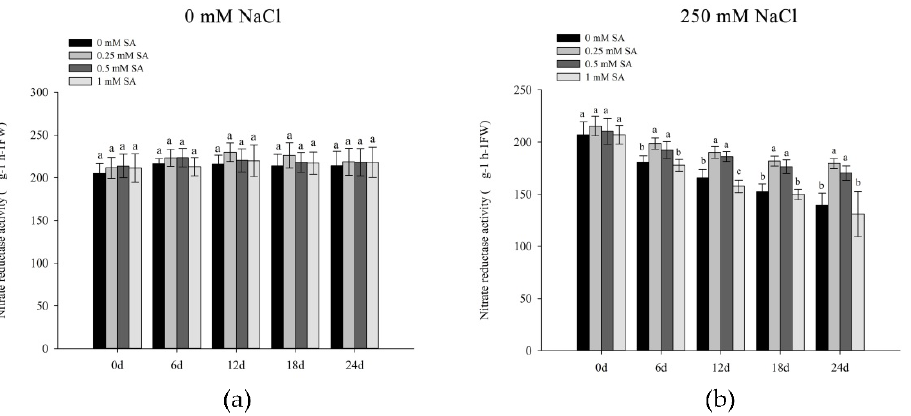
Figure 5. Effect of salicylic acid on nitrate reductase activity ( µ g g − 1 h − 1 FW) of perennial ryegrass under control ( a ) and 250 mM salt stress ( b ) conditions. The different letters indicate significant differences ( p ≤ 0.05) .